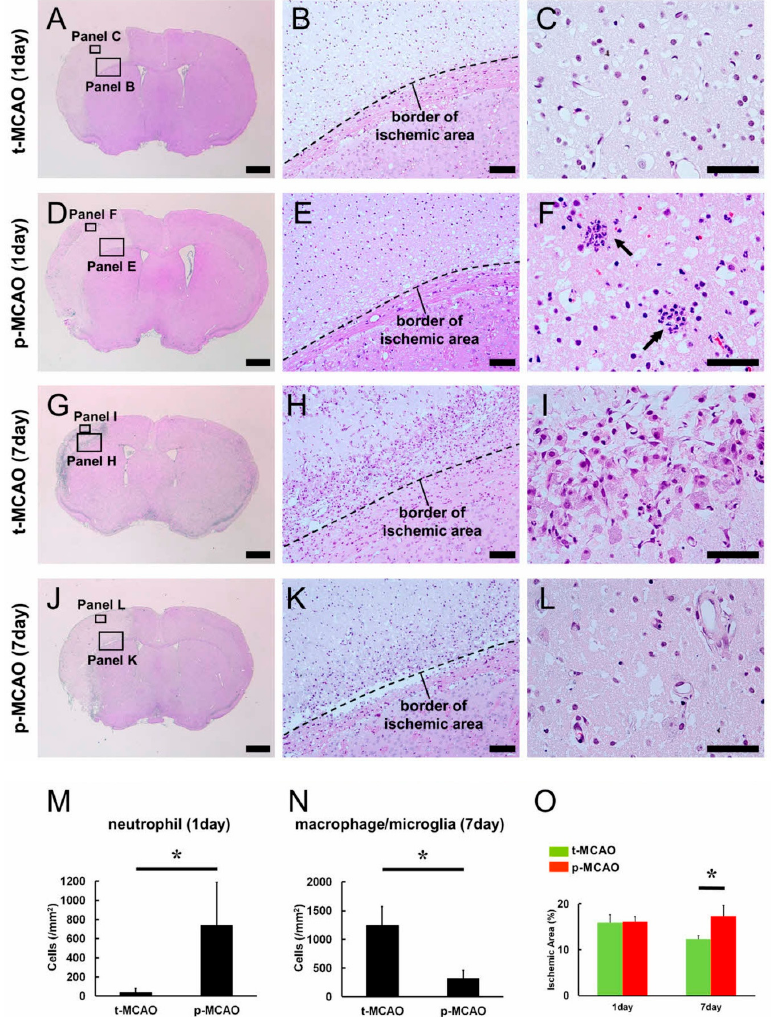
Figure 2. H&E staining of brain sections obtained following 90-min t-MCAO ( A – C and G – I ) and p-MCAO ( D – F and J – L ) at 1 d ( A – F ) and 7 d ( G – L ) post stroke. Ischemic changes indicating cell death characterized by nuclear pyknotic changes were observed within the ischemic areas ( B , E , H , K ). At 1 d post stroke, neutrophils were observed within ischemic areas after p-MCAO ( F , arrows, M ), and to a lesser extent after t-MCAO ( C , M ). At 7 d post stroke, more macrophages / microglia were observed within the ischemic areas after 90-min t-MCAO ( I , N ) compared to p-MCAO ( L , N ). The size of the ischemic areas was not significantly di ff erent between the groups at 1 d post stroke, but was significantly smaller 7 d after 90-min t-MCAO compared to p-MCAO ( O ). Results are representative of three replicates. Scale bars = 1 mm ( A , D , G , J ), 100 µ m ( B , E , H , K ), and 50 µ m ( C , F , I , L ). * p < 0.05 between stroke models (90-min t-MCAO vs. p-MCAO), within day ( M – O ) ( n = 3, for each model). Abbreviations: H&E, hematoxylin and eosin; p-MCAO, permanent middle artery occlusion; t-MCAO, transient middle cerebral artery